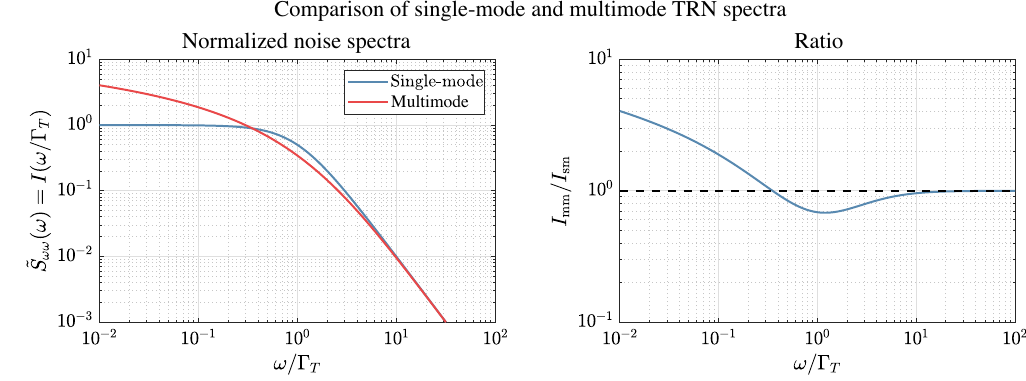
˜ S ωω ð ω Þ ¼ I ð ω = Γ for single-mode [Eq. (A31)] and multimode [Eq. (A30)] TRN in an infinite slab T Þ